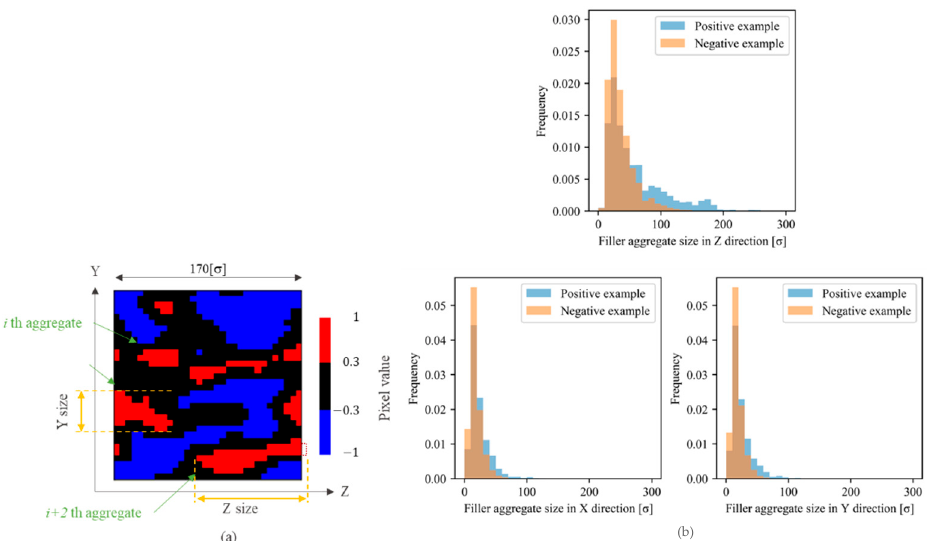
Figure 17. Example of the aggregate extracted by the CNN and size distributions of filler aggregates. ( a ) Cross-section of the convoluted image. The aggregate size is defined as the difference between the largest and smallest pixel coordinates. The red region is the set of pixels with positive values that contributes to the positive example. The blue region is the set of pixels with negative values that contributes to the negative example. The black region includes pixels with small values ranging from − 0.3 to 0.3 and does not affect the output. The adjacent red pixels are extracted as filler aggregates under the periodic boundary conditions. ( b ) Histograms of the size of the set of pixels with positive values, namely aggregate sizes, obtained from all morphologies in the positive (blue bars) and negative (orange bars) examples. Z is the elongation direction of the system.